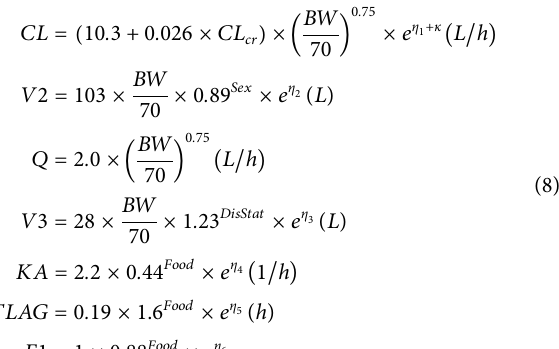
FO algorithm, seven covariates (CL cr , weight, sex, albumin, hemoglobin, food, and age) were preliminarily identi fi ed as signi fi cant covariates of PK parameters. Further screening by FOCEI algorithm con fi rmed that fi ve covariates (CL cr , body weight, DisStat, sex, and food) were signi fi cant covariates of nemonoxacin PK parameters: CL cr was the covariates on CL, while food was the covariate on K a , T lag and F. Sex was the covariate on V2. Disease status (DisStat) was the covariate on V 3 . Body weight was the covariate on CL, V 2 , Q and V 3 .